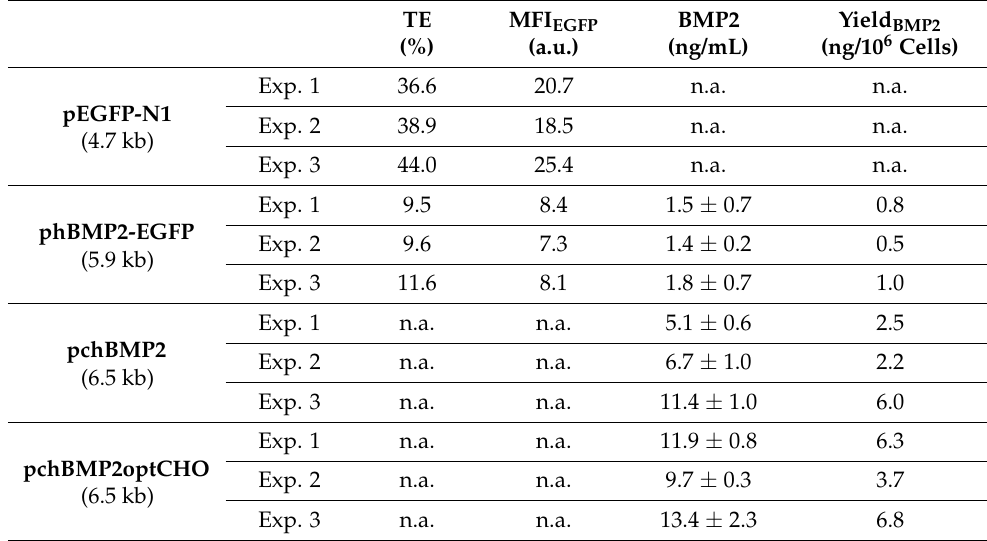
TE MFI EGFP BMP2 (%) (a.u.) (ng/mL)